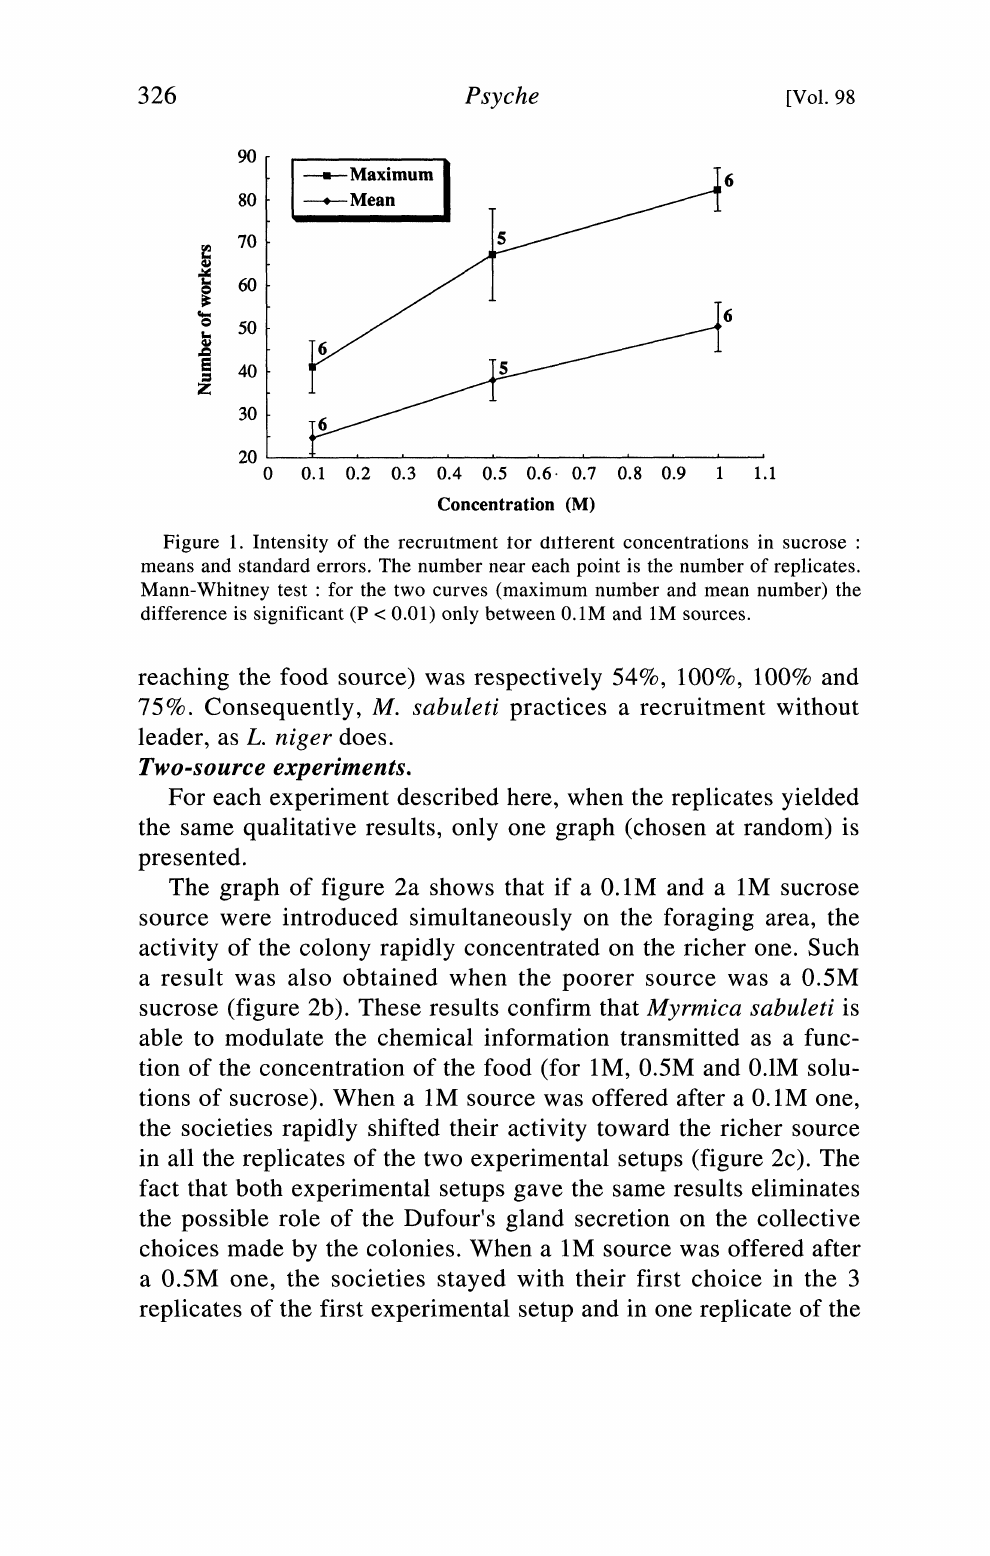
Figure 1. Intensity of the recruitment tor dnterent concentrations in sucrose means and standard errors. The number near each point is the number of replicates. Mann-Whitney test for the two curves (maximum number and mean number) the difference is significant (P < 0.01) only between 0.1M and 1M